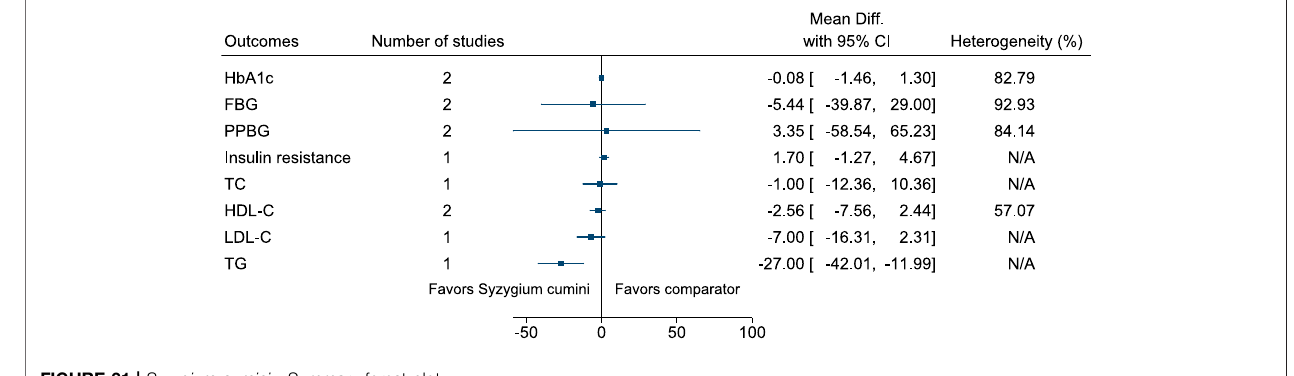
FIGURE 31 | Syzygium cumini — Summary forest plot.